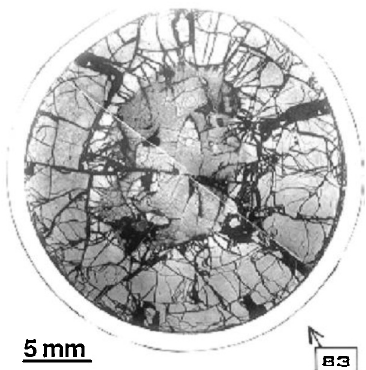
Fig. 4. B 4 C pellets (from Ref. [4]) irradiated in the French LMFBR Phenix. 1.2 (cid:1) 10 22 capt./cm 3 (about 12 at.% total